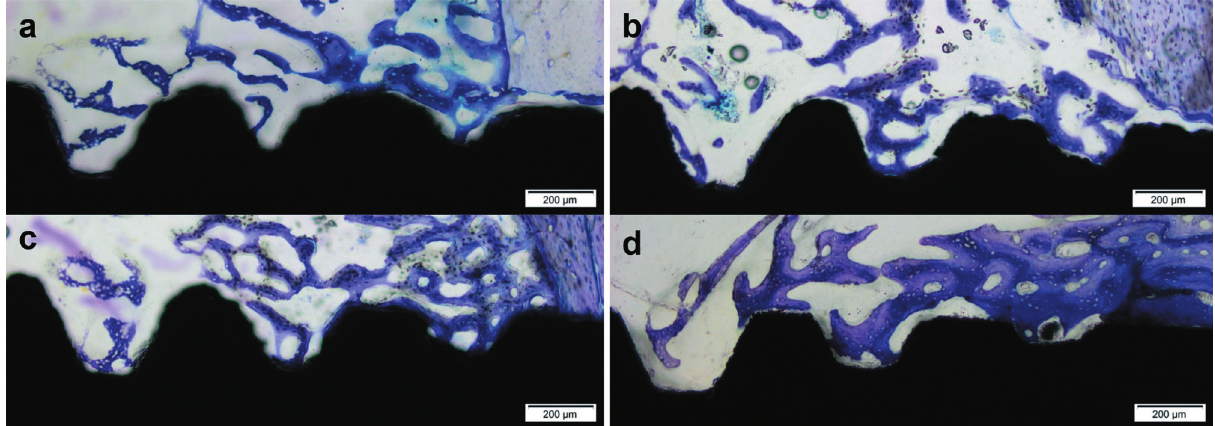
Figure 4- Photomicrographs of toluidine blue stained thin sections of the Group 1 at 14 days (a) and 28 days (b) and Group 2 at 14 days (c) and 28 days (d) in bright field (original magnification 10X). Observe the presence of new bone formation in the area between threads and the contact between bone and both implant groups. In Group 2 at 28 days, see the presence of trabecular bone more compact and in a greater number than Group 1 at the same period, suggesting the acceleration